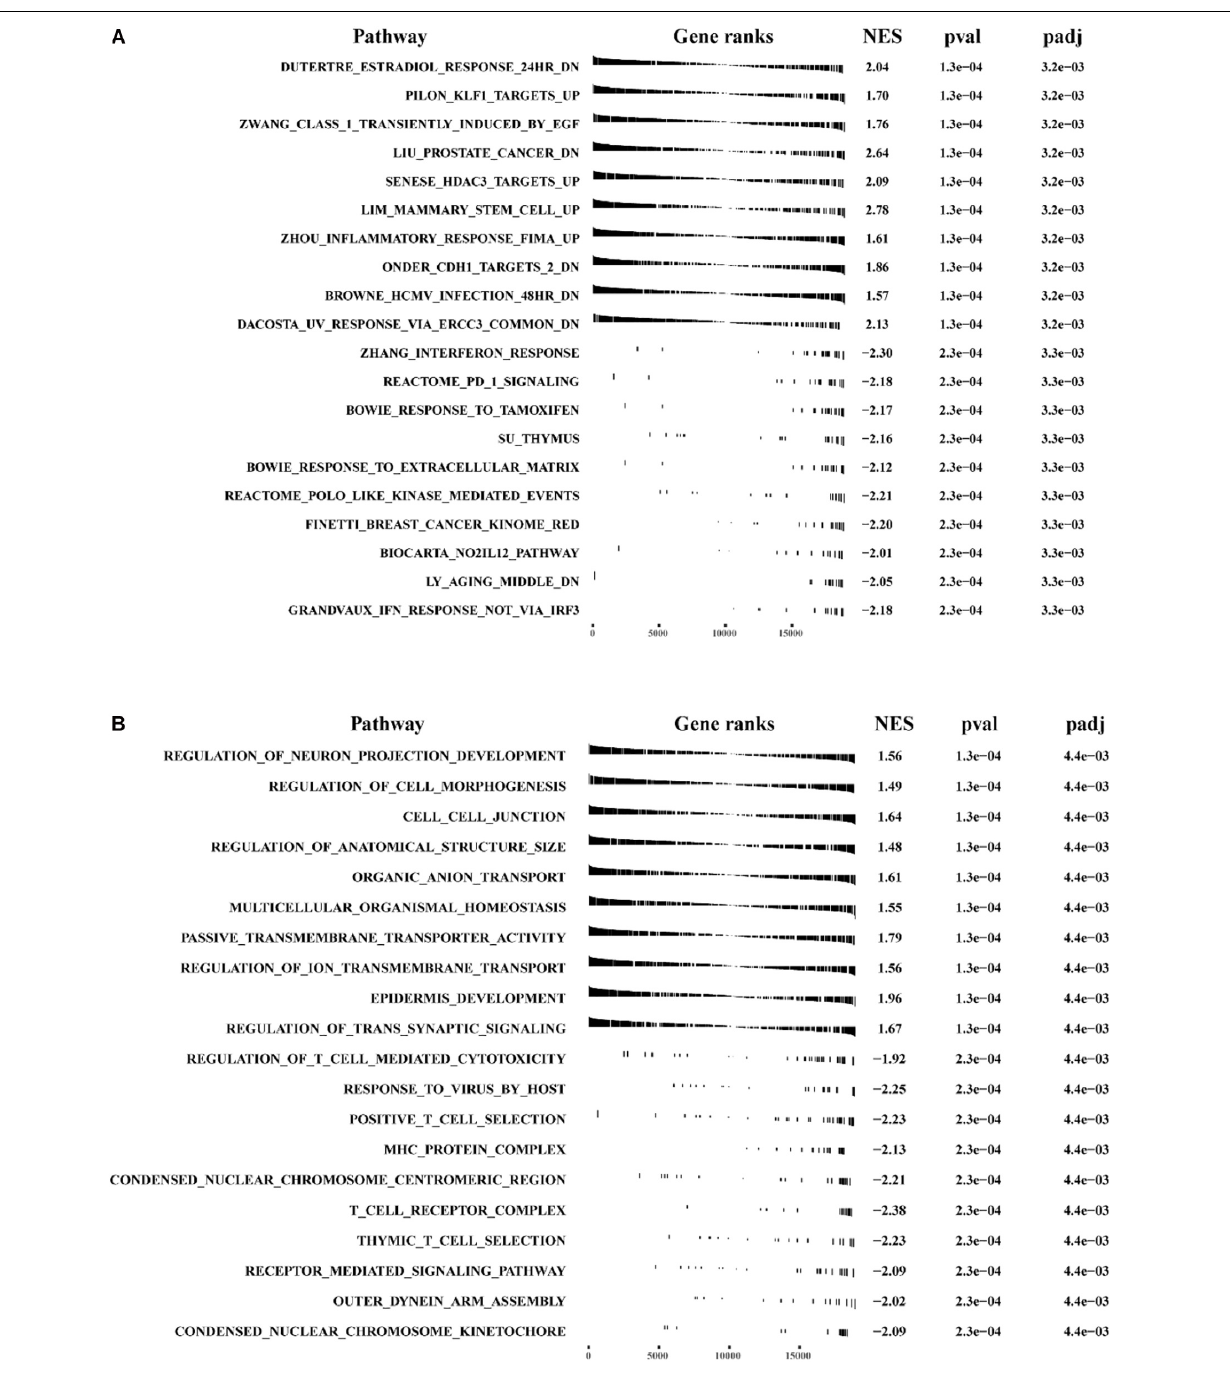
immune cells and the lncRNAs in the signature (